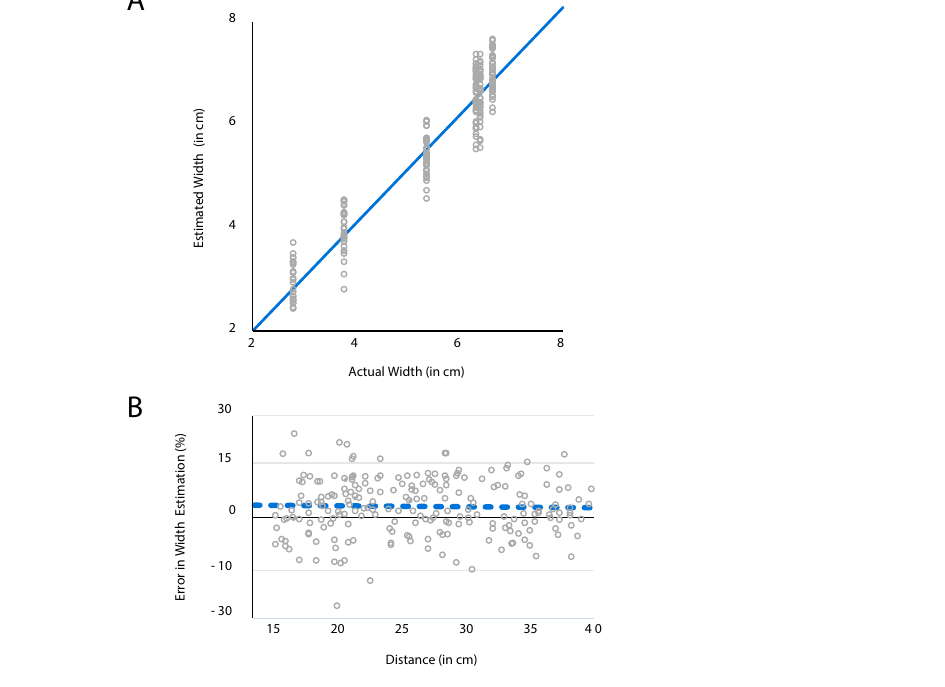
Figure 8. ( A ) Discrepancy between calculated and actual width; ( B ) Estimation error (%) versus the distance between the participant and the target object.